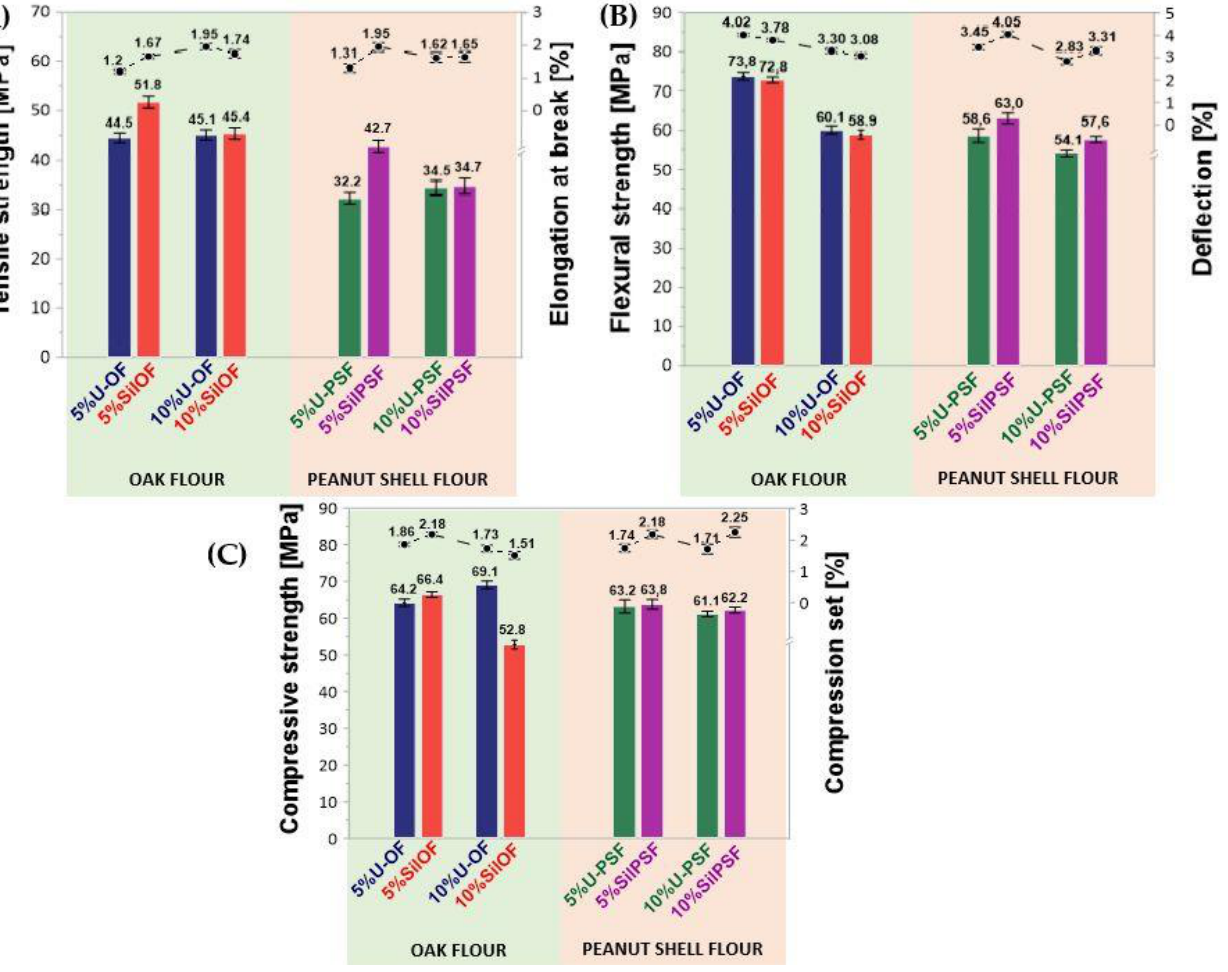
Figure 5. Mechanical properties of compositions based on Epidian 6 filled with wood or peanut shell flour: tensile strength and elongation at break ( A ), flexural strength and deflection of compositions ( B ), and compressive strength and compression set ( C ).